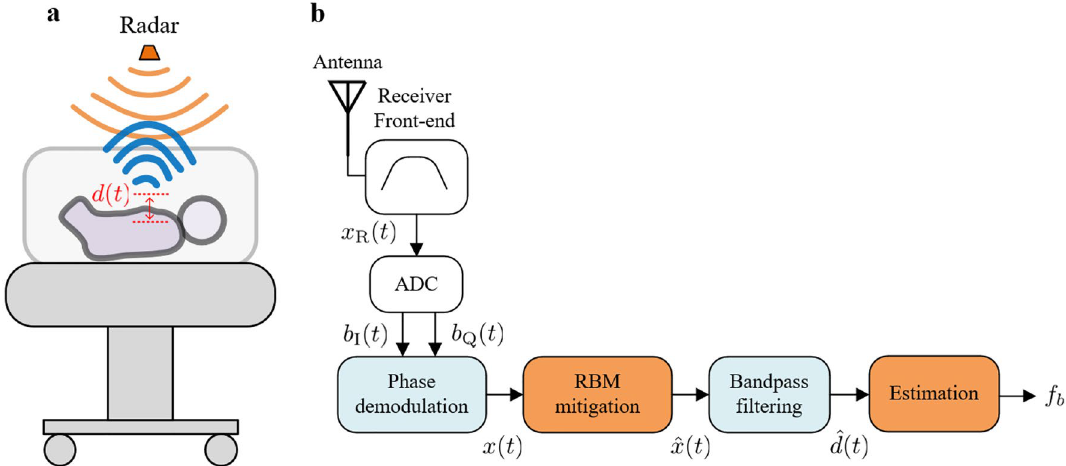
Figure 1. Continuous-wave radar for breathing monitoring in the NICU. ( a ) Basic operational principle. ( b ) Block diagram of the signal processing chain. Before estimation, the received signals from the analog-to- digital converter (ADC) are phase demodulated and further processed in the random body movements (RBM) mitigation